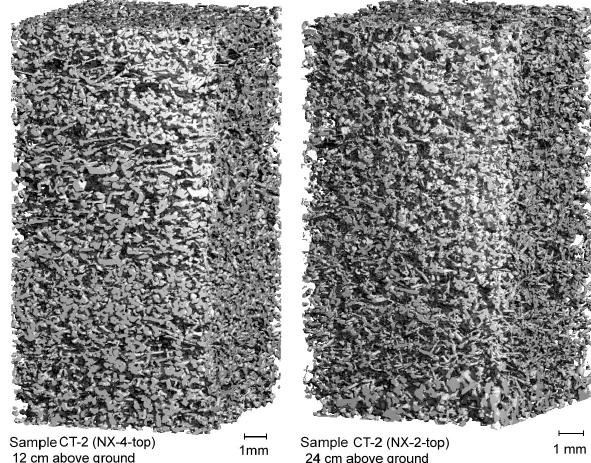
Figure 14. Two samples from the profile CT-2 (21 December 2011) taken 12cm (left panel) and 24cm (right panel) above ground. Hor- izontal structures are clearly visible in the left image but can also be identified in the right image. The CT-based average anisotropy of the two samples are A CT avg =+ 0.26 (left panel) and + 0.16 (right panel). The vertically resolved anisotropy, A CT , determined every 2mm depth by means of µ CT, is plotted in Fig. 16b for both sam- ples as blue dots.